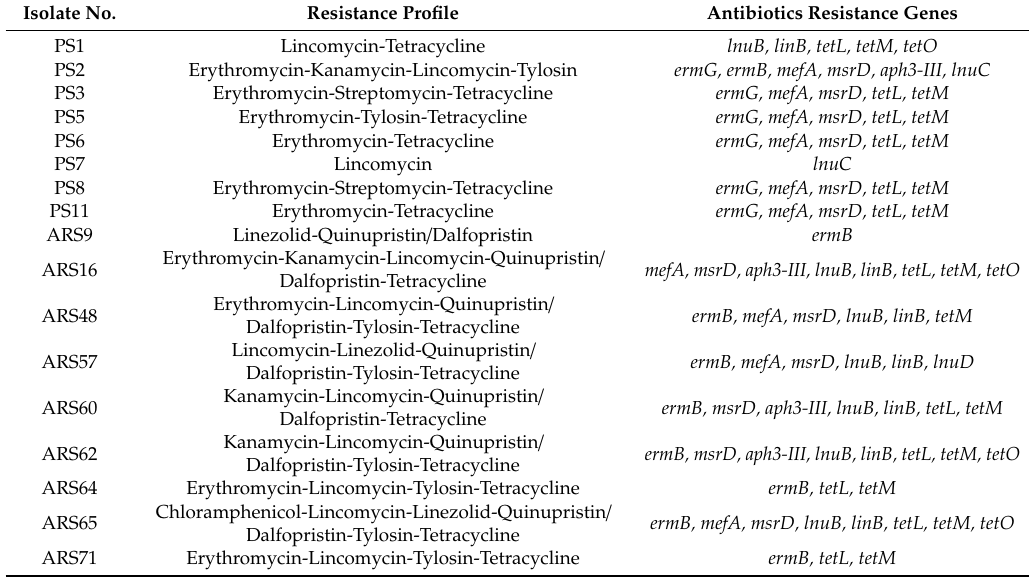
Table 1. Antibiotic resistance profile of clinical and non-clinical Enterococcus cecorum isolates. Isolate No. Resistance